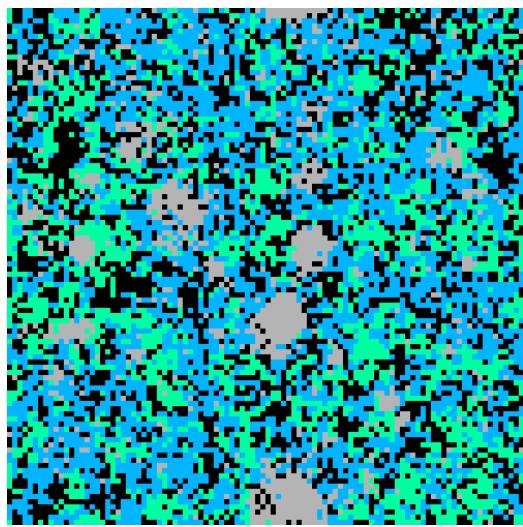
Figure 4. Partially hydrated artificial microstructure from CEMHYD3D; one slice showing a cross-section 100 × 100 µm with a resolution 1 pixel (voxel)=1 µm; color map corresponds to Figure 3.